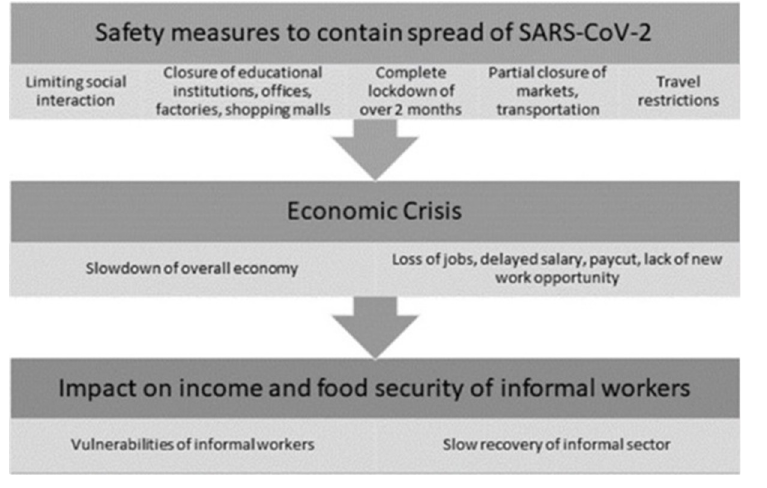
Fig 1. Conceptual